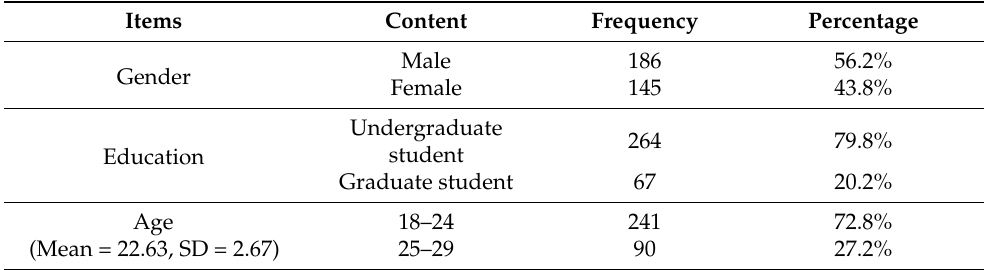
Table 1. Sociodemographic characteristics of participants (n =